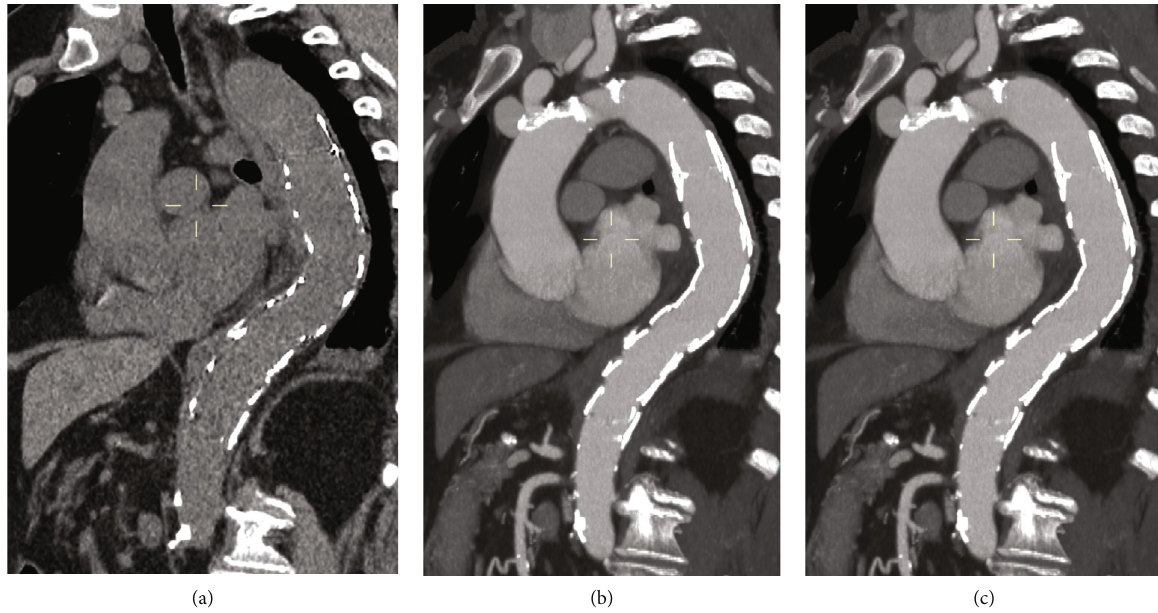
Figure 6: After 1 month, CTA reported a complete reabsorption of the IMH and a complete exclusion of the PAU and ULP (a –